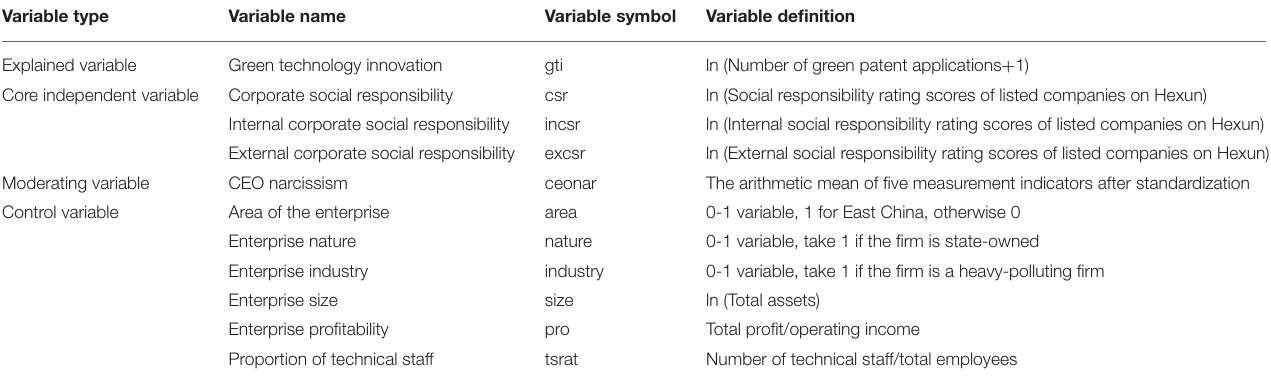
TABLE 3 | Variable definitions and